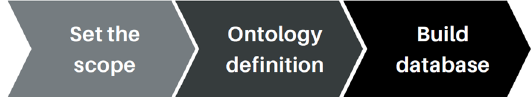
Figure 3. Pipeline of the methodology for ontology building.